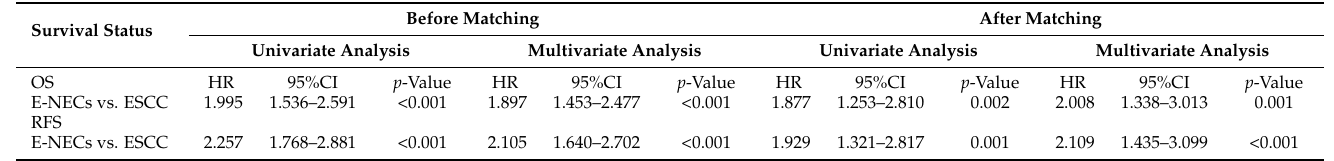
sociated with OS and RFS are shown in Figures S3 and S4. Table 3. Univariate and multivariate analysis of the histology related to overall survival and recurrence-free survival #